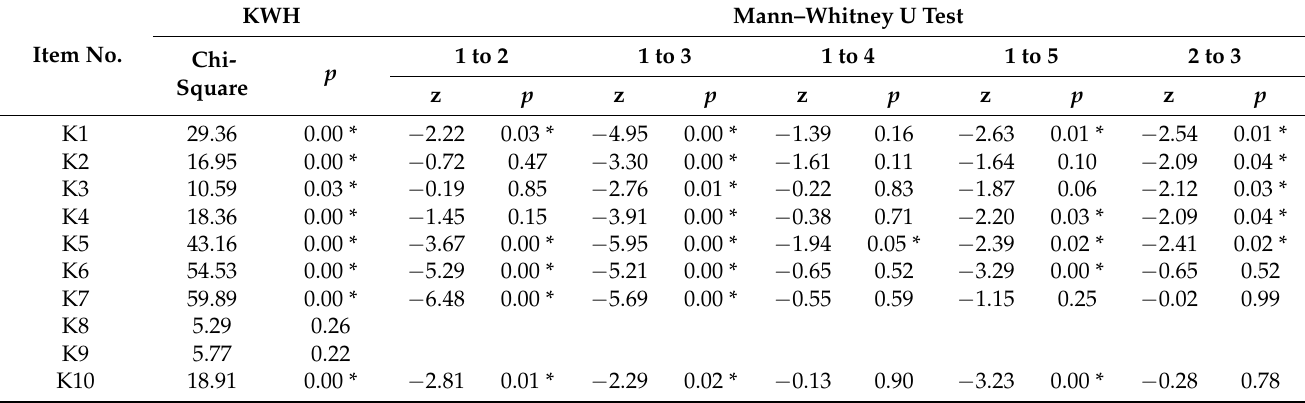
Table 10. Kruskal–Wallis test for differences between FFFs’ knowledge and experience